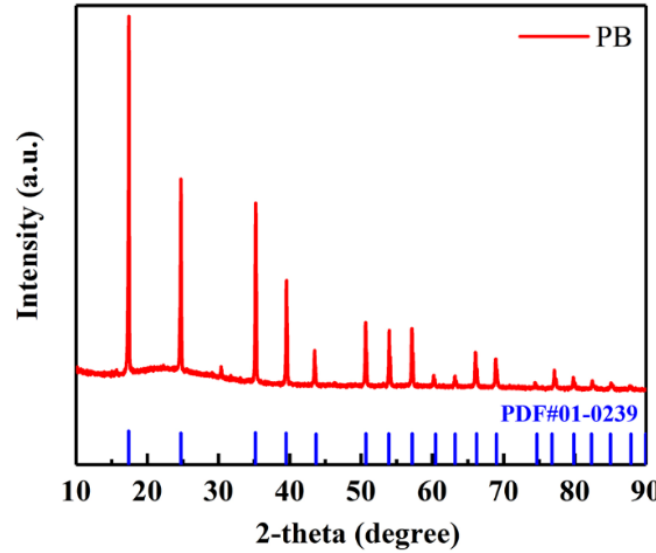
Figure 1. XRD pattern of Fe-based Prussian blue MOF.